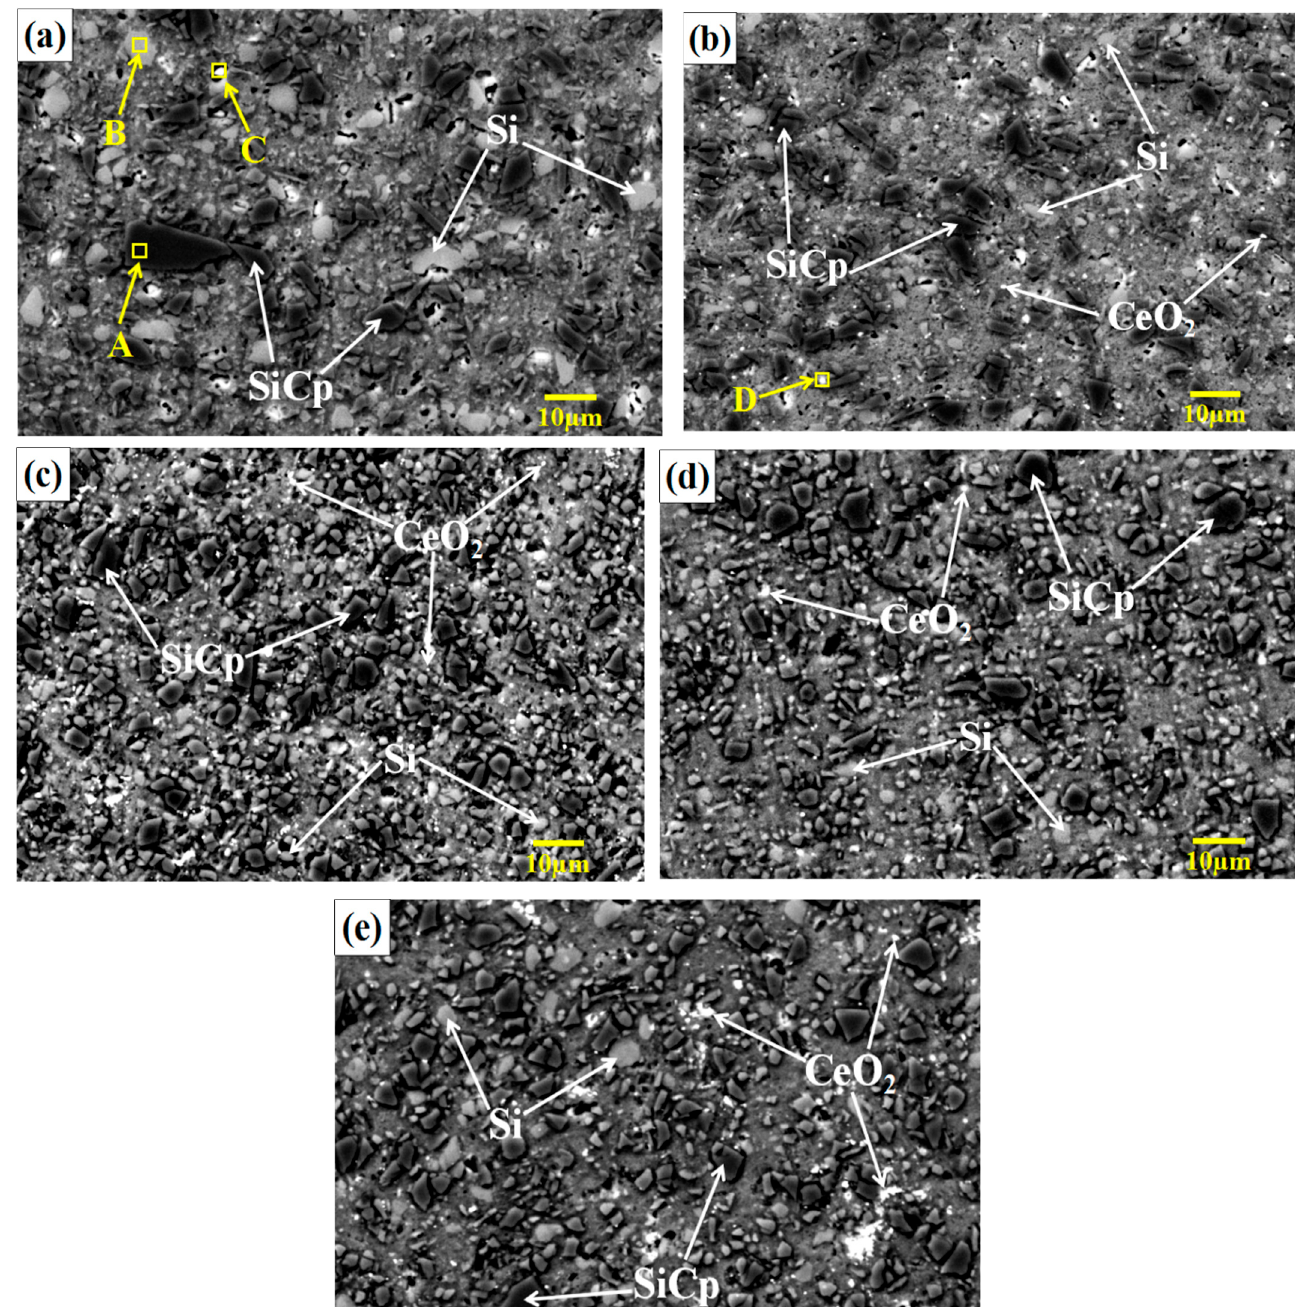
Figure 2. The SEM images of SiCp/Al-Si composites with different CeO 2 volume fraction: ( a ) 0; ( b ) 0.1 vol%; ( c ) 0.2 vol%; ( d ) 0.3 vol%; ( e ) 0.4 vol%.